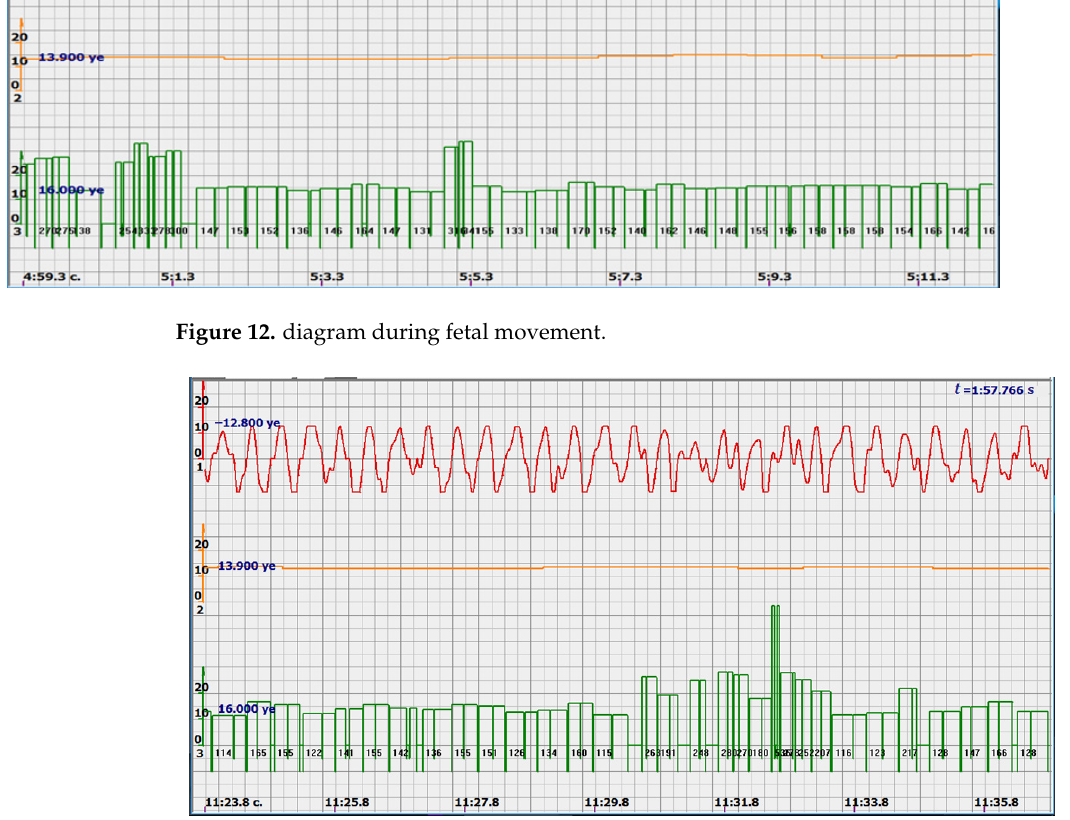
Figure 13. Fetal movements that are not responded to by the heart rate measurement system, which calculates the spectra of ultrasonic signals .